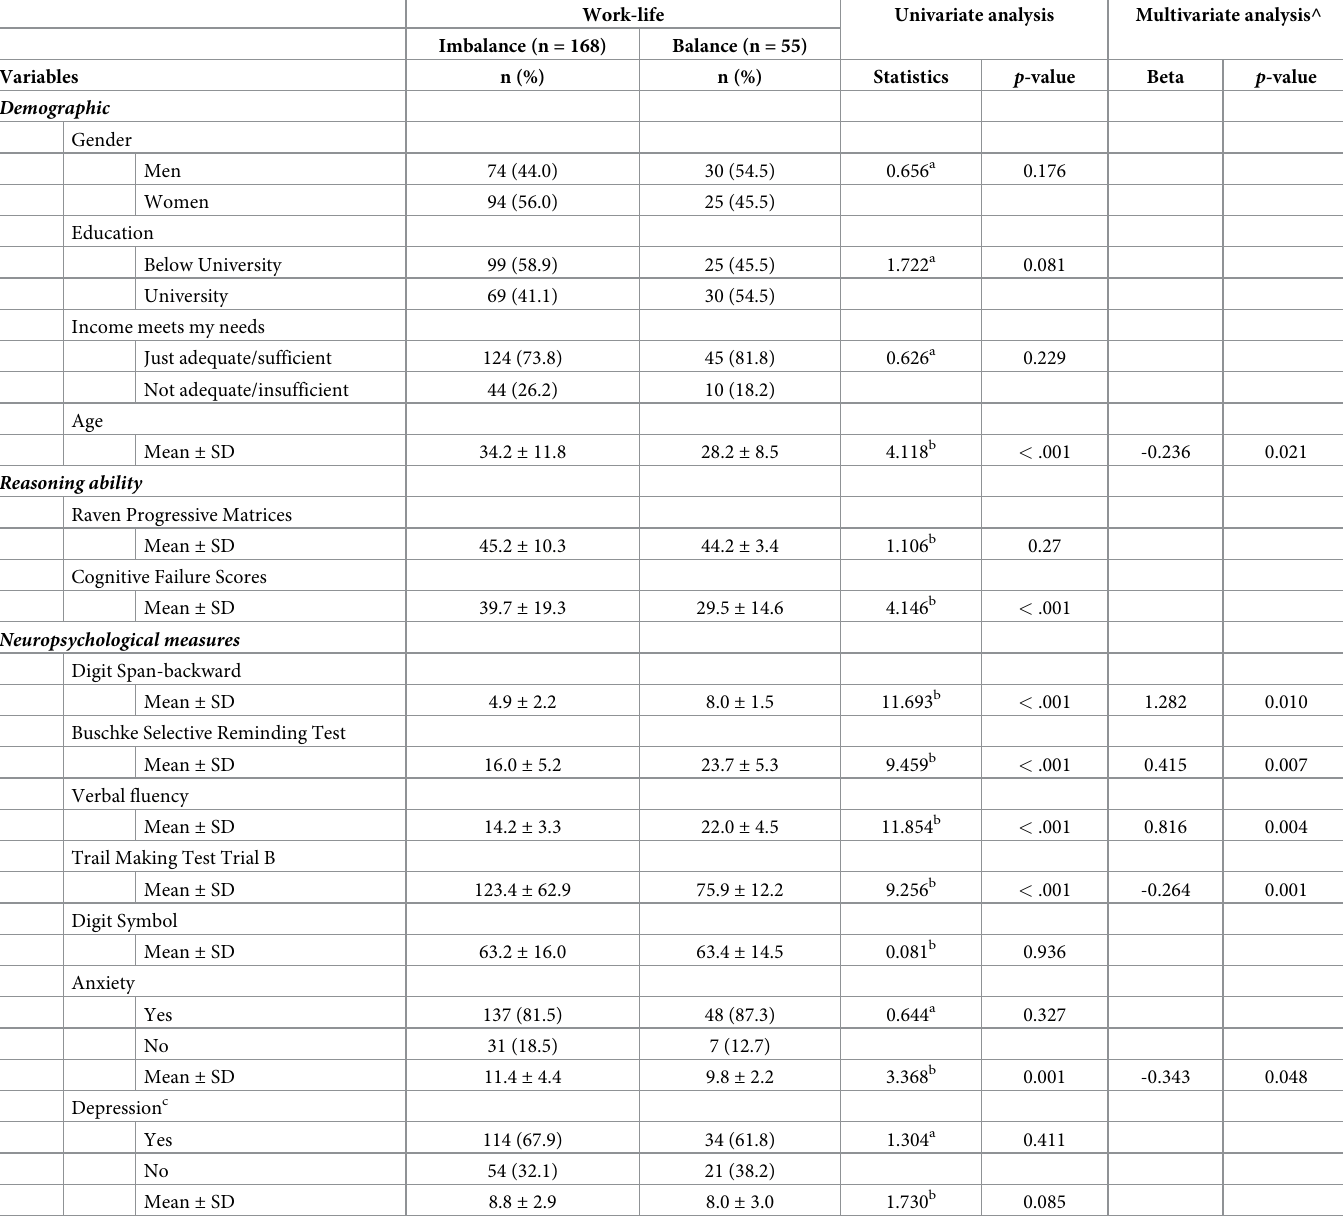
Table 2. Univariate and multivariate (multiple logistic regression) analysis for work-life imbalance in association with demographic, reasoning ability, and neuro- psychological